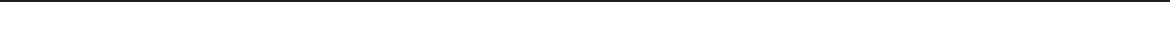
Fig. 2 Structure and organization of the E-proteins and M-proteins in TBEV virion. a Dimer of E-proteins with domain I colored in red, domain II in yellow, domain III in violet, and domain IV in blue. The electron density map of one of the proteins is shown as a semi-transparent surface. Glycosylation site Asn157 and residues Trp101 and Phe108 from the fusion loop of domain II are shown in detail. b Heterotetramer of two E-proteins and two M-proteins. E-proteins are colored according to domains, and M-proteins are shown in orange. c Superposition of cryo-EM (colored) and X-ray (gray) E-protein structures 27 . The cryo-EM structure includes three perimembrane (h1 – h3) and two transmembrane helices (h4 and h5). d M-protein rainbow-colored from N-terminus in blue to C-terminus in red with electron density map shown as semi-transparent surface. The M-protein consists of an extended N-terminal loop followed by perimembrane (h1) and two transmembrane helices (h2 and h3). e Molecular surface of E – M heterotetramer. Histidines with a putative role in the dissociation of the heterotetramers are shown in magenta. Insets show details of interactions of the histidine side chains. f Structures of E-proteins and M-proteins colored according to conservation of amino acid sequence among viruses from the family Flaviviridae (for more details, see Supplementary Fig. 5). Insets show the conservation of histidines that might be involved in the pH-dependent dissociation of the heterotetramers. g Molecular surface of E – M heterotetramer colored according to electrostatic potential at pH 8.5 and 5.8. One E – M heterodimer is shaded for clarity. Insets show the surface potential surrounding the histidines that might be involved in the pH-dependent dissociation of the hetrotetramer. The table in the middle lists the pKa values of the selected histidines calculated using Rosetta-pKa